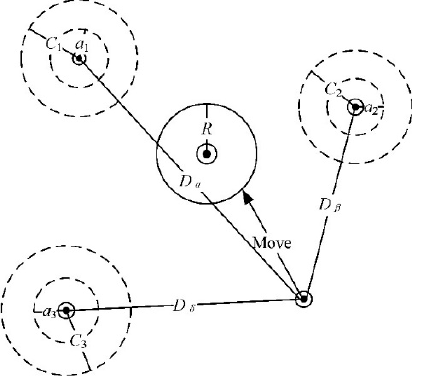
Figure 1. Position updating in GWO.